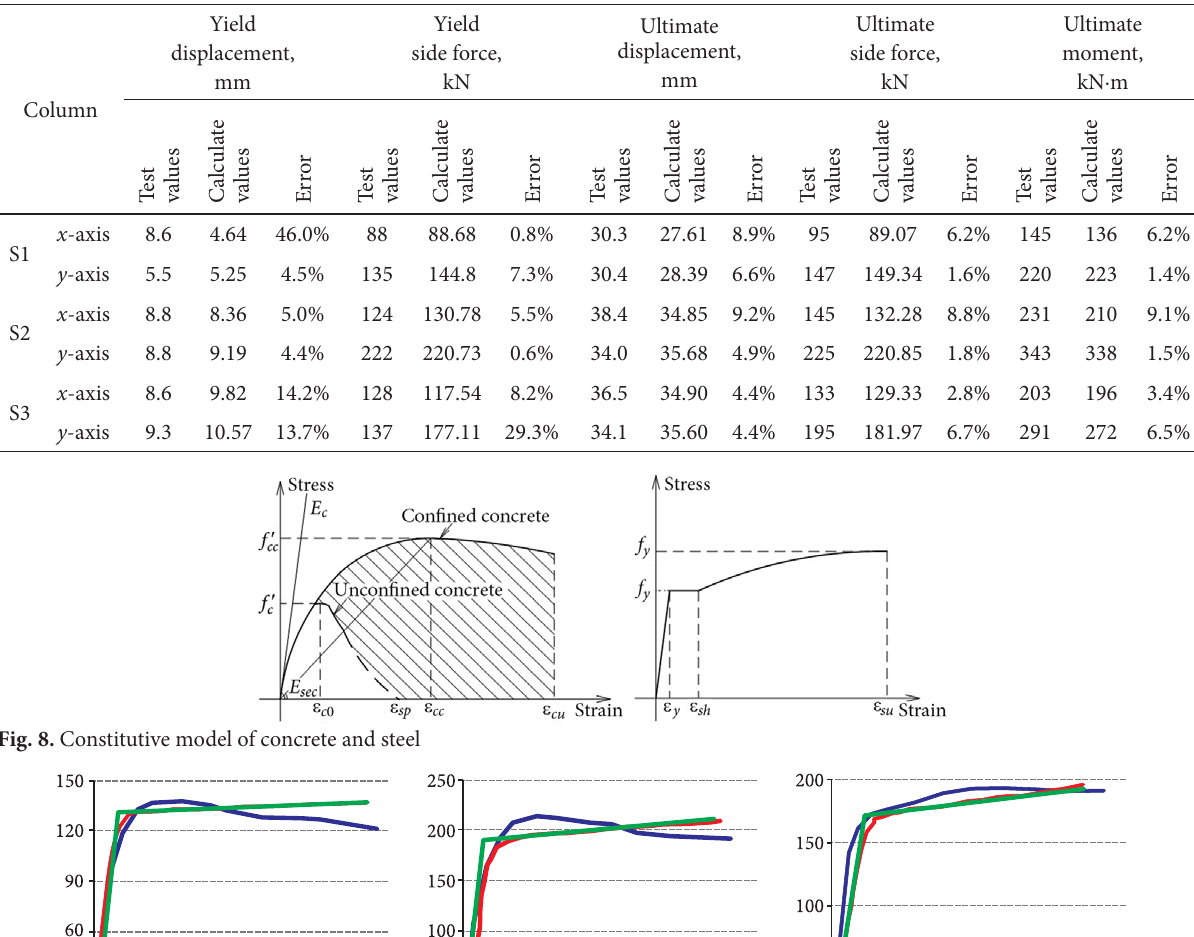
Fig. 8. Constitutive model of concrete and steel